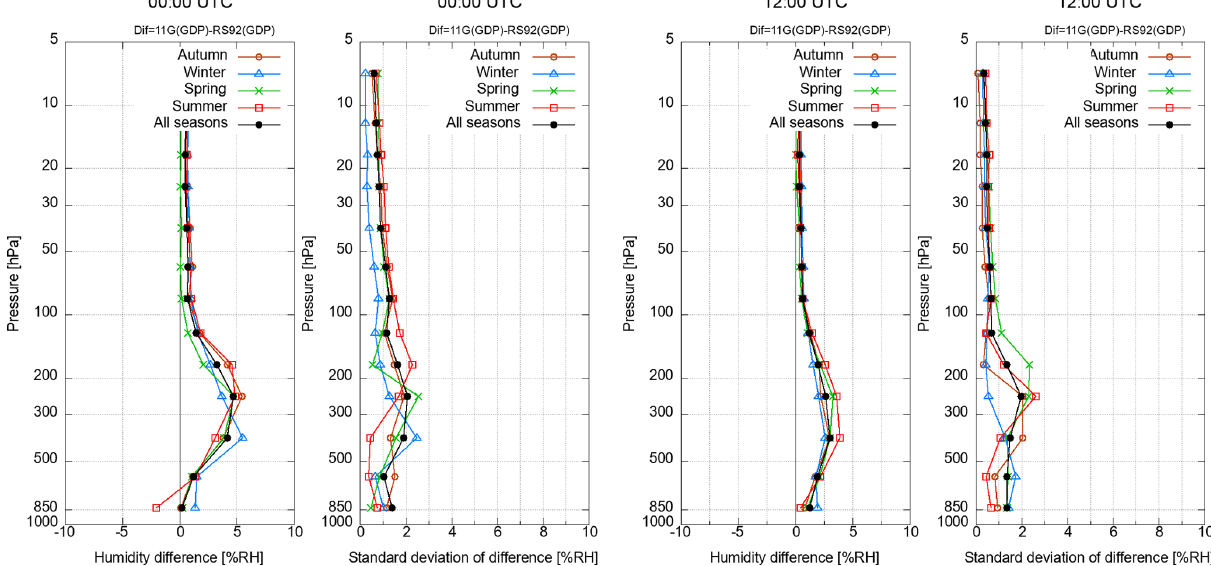
Figure 11. As per Fig. 10, but for